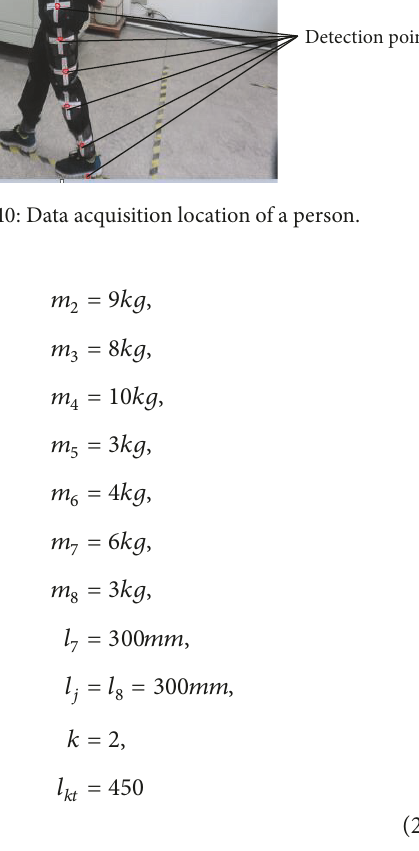
Detection points